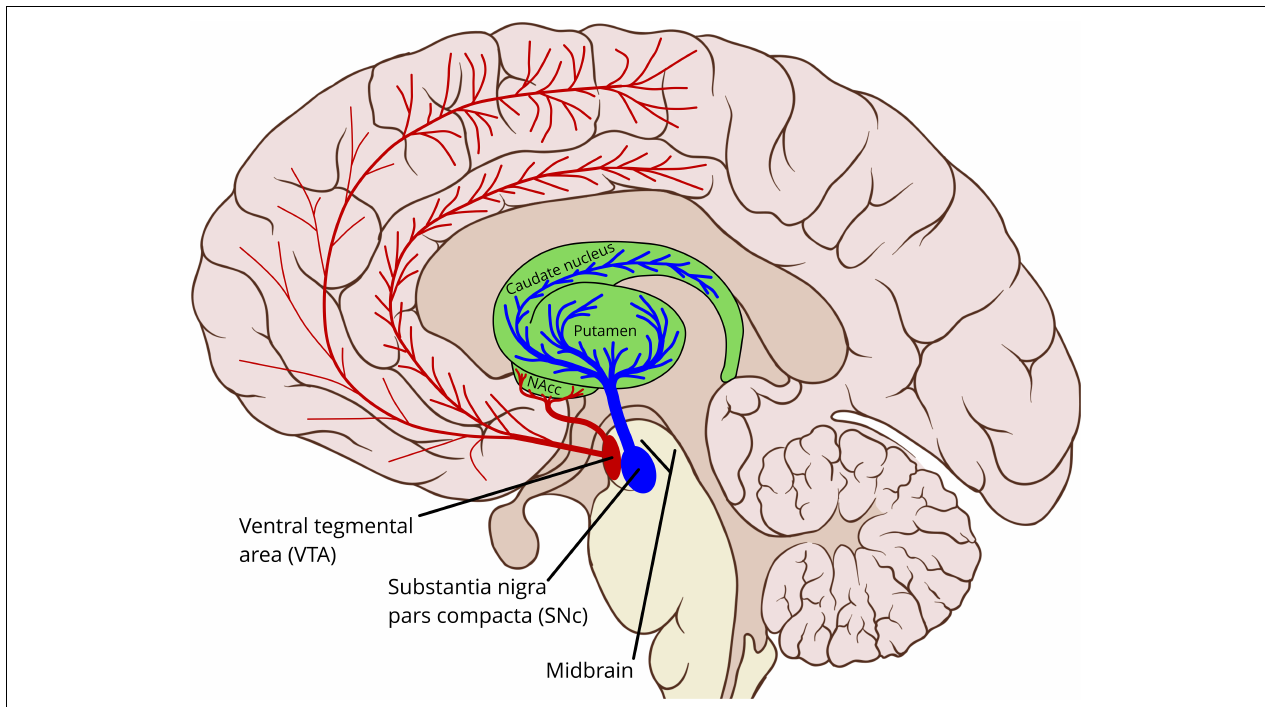
FIGURE 1 | Schematic outline showing the midbrain dopaminergic sources and main pathways to the striatum and the cerebral cortex. In particular the cortical pathways are incompletely characterized, and motoric cortical regions may be innervated by both the VTA and the SNc (Gaspar et al., 1989; Björklund and Dunnett, 2007; Hosp et al., 2019). VTA, ventral tegmental area; SNc, substantia nigra pars compacta; NAcc, nucleus accumbens (The background sagittal brain view is from Patrick J. Lynch, medical illustrator, CC BY 2.5 < https://creativecommons.org/licenses/by/2.5 > , via Wikimedia Commons, https://commons.wikimedia.org/wiki/File:Brain_human_sagittal_section.svg. Illustration of the basal ganglia and the dopamine pathways by Per A.